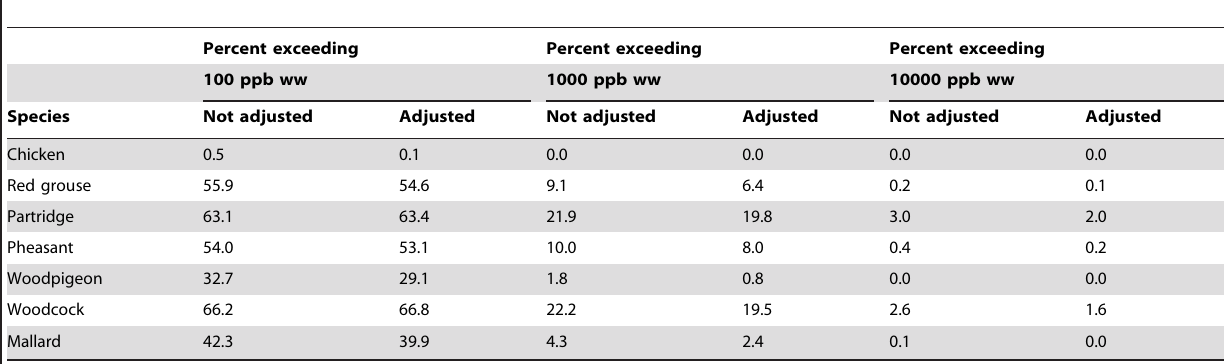
Table 4. Percentages of samples of cooked gamebirds and chicken estimated from fitted lognormal models to have exceeded each of three threshold values of lead concentration (100, 1000 and 10000 ppb wet weight).